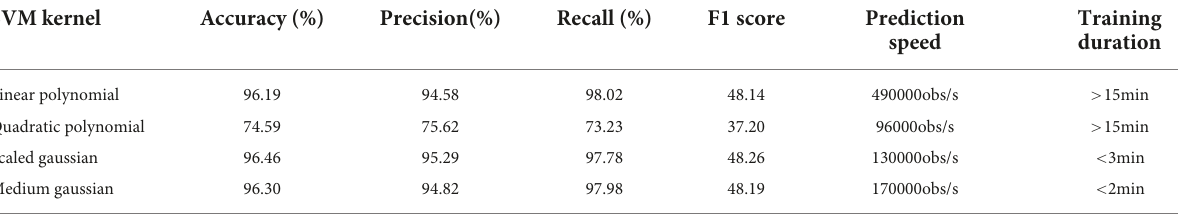
TABLE 7 The detailed performance of different SVM kernels *.